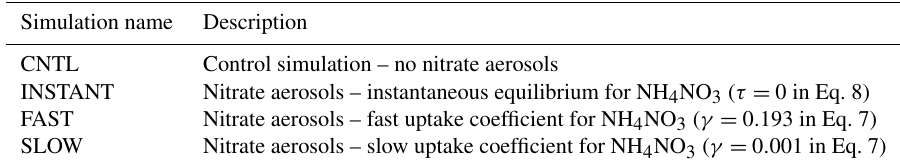
Table 2. A description of the UM simulations performed in this